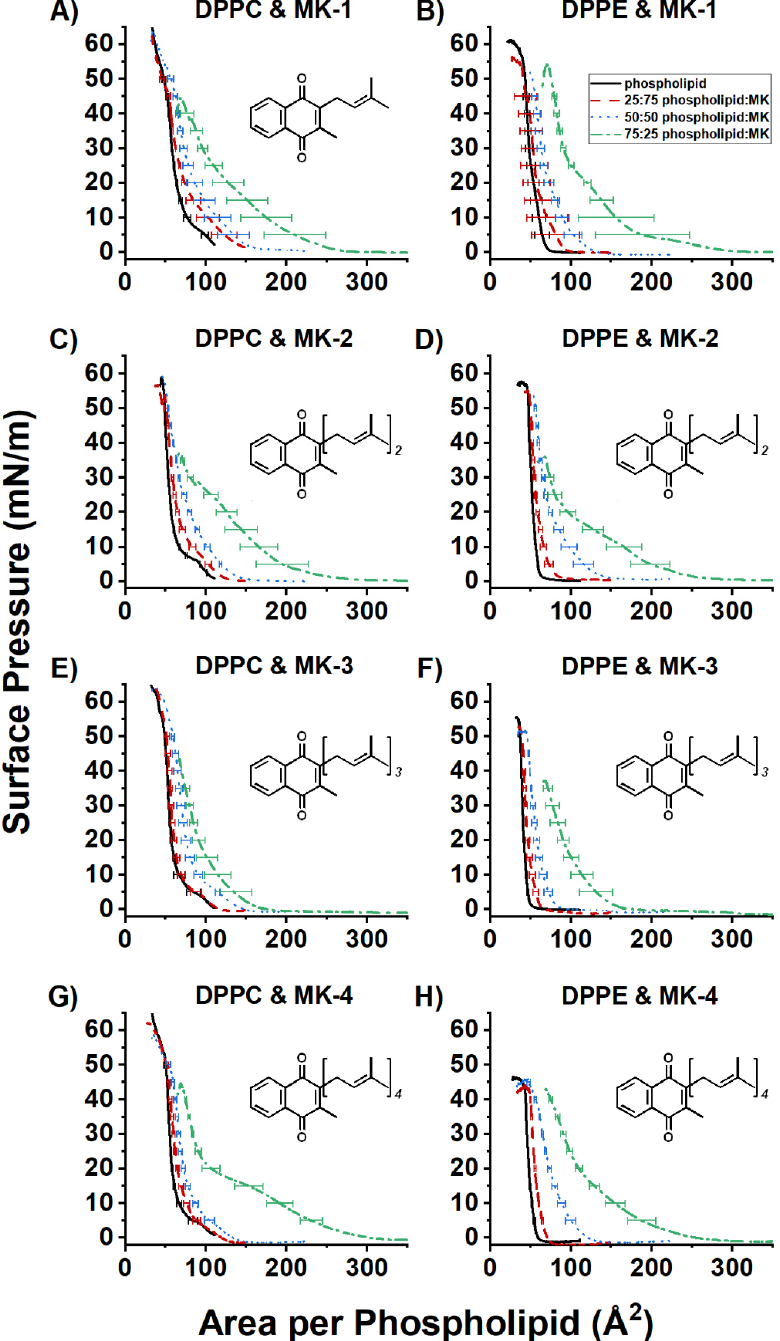
Figure 5. Normalized compression isotherms of mixed monolayers of either DPPC (left column) or DPPE (right column) with MK. Panels ( A ) and ( B ) are MK-1, ( C ) and ( D ) are MK-2, ( E ) and ( F ) are MK-3, and ( G ) and ( H ) are MK-4. Pure phospholipid monolayers are represented with solid black curves, 75:25 phospholipid:MK with red dashed curves, 50:50 phospholipid:MK with blue dotted curves, and 25:75 phospholipid:MK with green dash-dot curves . Each curve is the average of at least three replicates. Error bars are the standard deviation at every 5 mN/m of surface pressure. Data for MK-1 and MK-2 were previously reported [6,7].